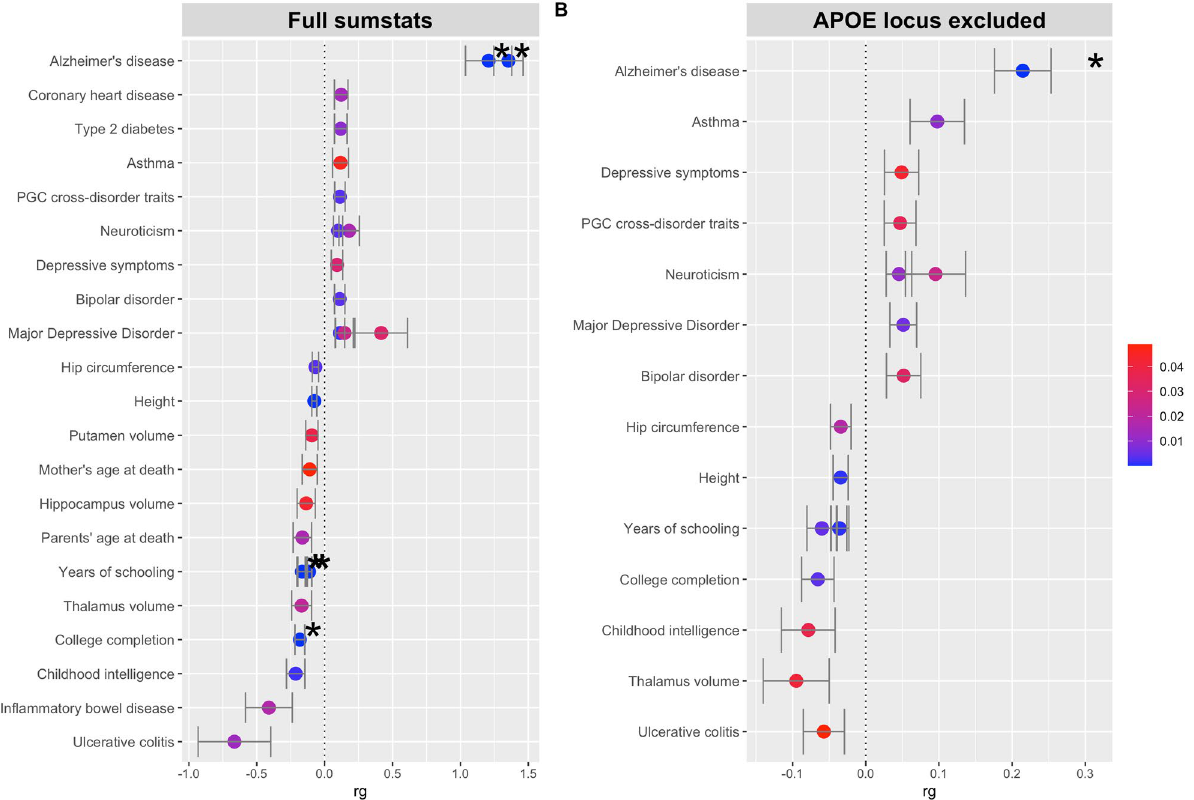
Figure 5. Genetic correlation of most significant MRC IEU traits. Most significant (p < 0.05) correlations from ldsc analysis of OpenGWAS ieu-a traits. Results are shown for the full sumstats (no loci excluded) ( A ) and in the absence of the APOE locus ( B ). Color of points denotes p value. Asterisk indicates p value below